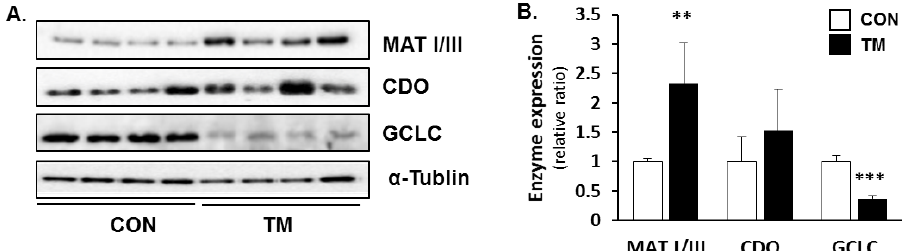
Figure 5. Changes in protein expression of enzymes involved in transsulfuration pathway after TM treatment. ( A ) Protein expression of hepatic methionine adenosyltransferase (MAT) I/III, CDO, and the catalytic subunit of GCL (GCLC) were determined by immunoblot analysis in TM-treated mice (2 mg/kg body weight), and ( B ) were quantified densitometrically. Each value represents the mean ± SD. ** and *** Statistically significant difference between control (white) and TM-treated mice (black) at p < 0.01 and < 0.001, respectively (Student’s t -test).